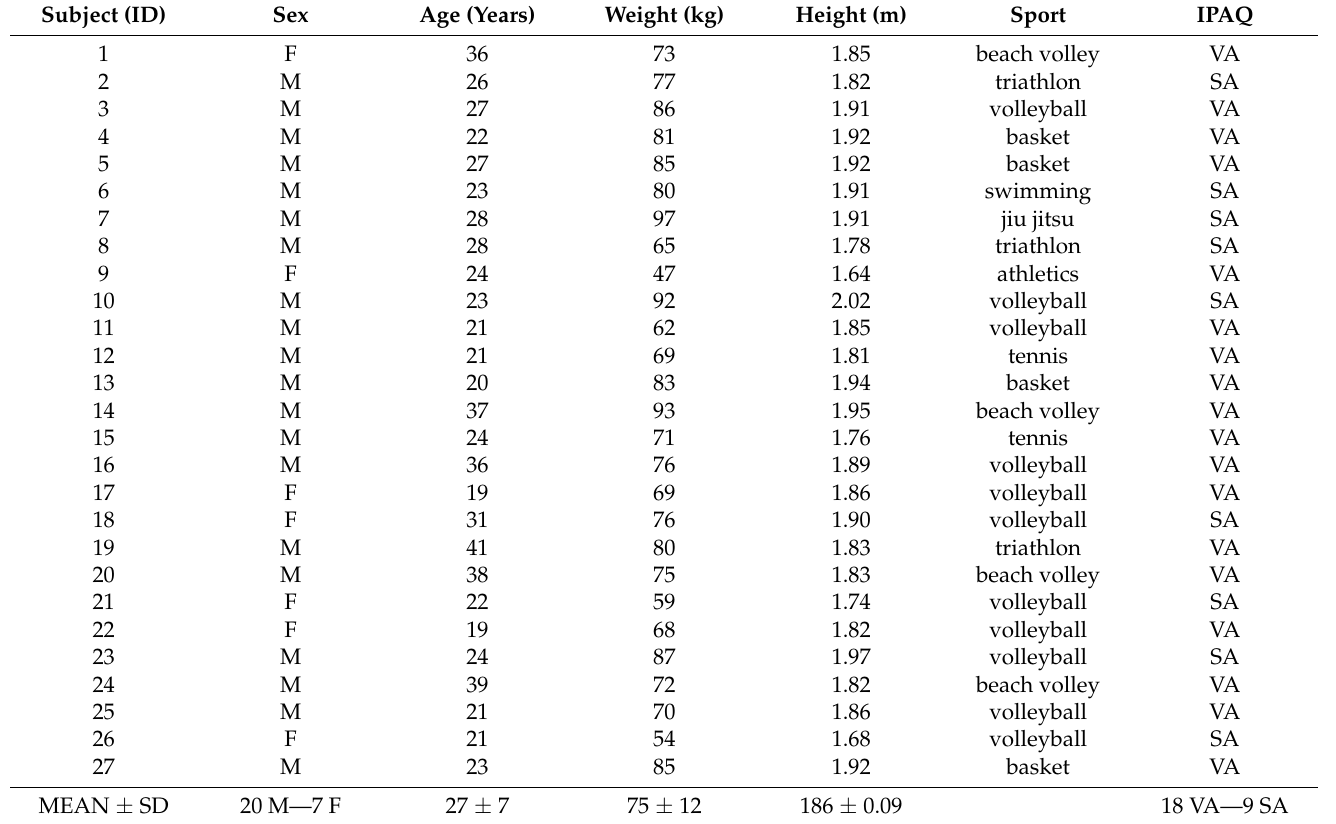
Table 1. Subject anthropometric characteristics, sports performed, and IPAQ